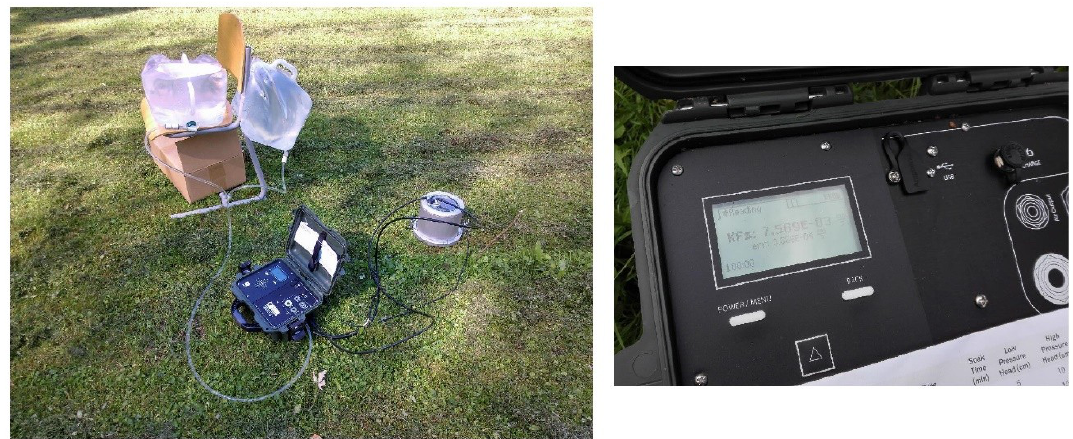
Figure 3. Field measurements of K s using dual head infiltrometer (DHI) on the study plot and DHI screen.